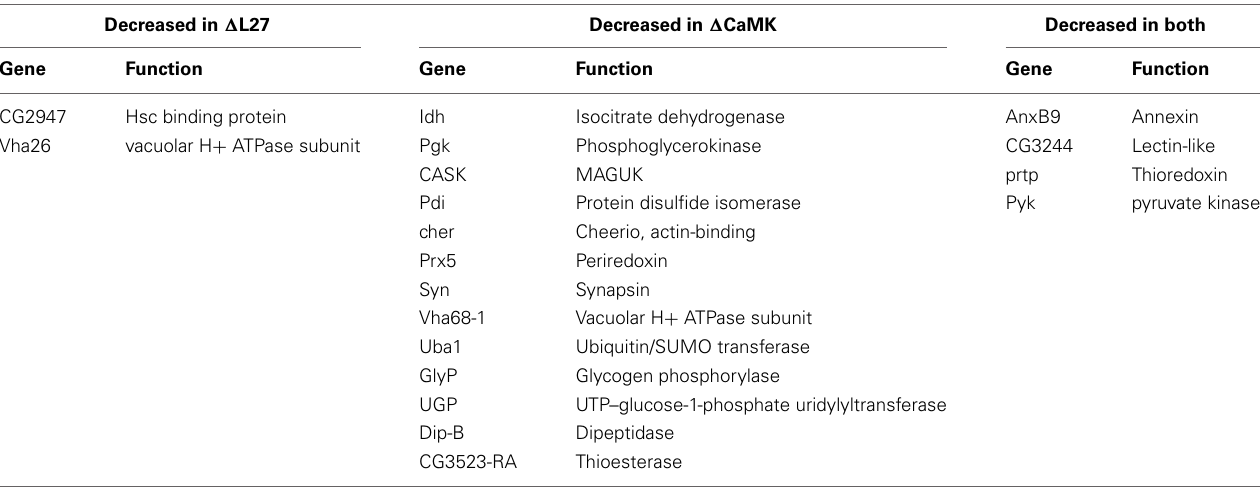
Table 2 | Domain-specific CASK interactions in dopaminergic